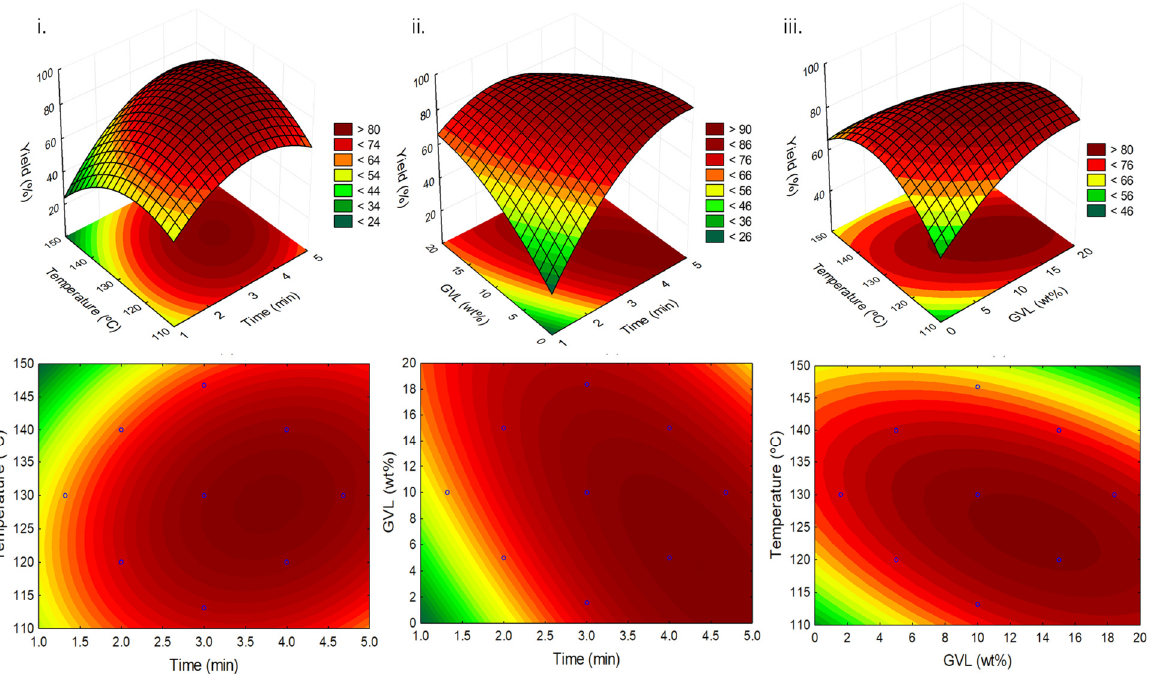
Figure 4. Response surface (top) and contour plots (bottom) of the 5-HMF yield using DES [Ch]Cl:CA (1:1) with the combined effects of: ( i ) temperature and time; ( ii ) GVL wt.% and time; and ( iii ) temperature and GVL wt.%.